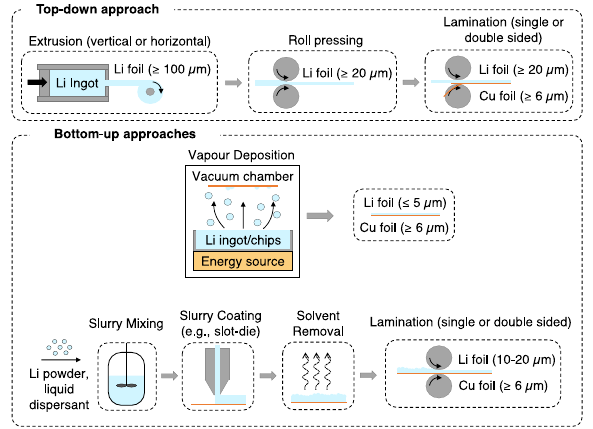
Fig. 5 | Production of lithium metal foils and electrodes. Top) Top-down method,i.e.,extrusionoflithiummetalingotstoproducelithiummetalfoilswitha minimum thickness of 100 µ m. Thickness can be reduced to a minimum of ca. 20 µ m by roll pressing. The foil can then be laminated on current collectors, such as copper. Bottom) Bottom-up approaches. The upper part of the bottom panel depicts asimpli fi edscheme of aphysicalvapour deposition method forproducing lithium foil. A lithium source, such as an ingot or chips, is placed in a vacuum chamber. Mechanical, electromagnetic, or thermal energy is then applied to the lithium source to vaporize the metal, which is deposited on a current collector, suchascopper,toactasanelectrode.Thelowerpartofthebottompaneldepictsa method for lithium ink deposition, wherestabilizedlithium particles are dispersed in a liquid (slurry mixing), and the slurry is coated on a foil and dried. The lithium metal electrode can then be thinned and laminated to homogenize and fl atten the (Fig. 5) 129 . Conventional lithium metal foil manufacturing (Fig. 5 top, top-down approach), generally carried out under a dry or inert atmo- sphere (which can add to processing costs), includes an extrusion process, and leads to foils with a minimum thickness of 100 µ m 130,131 . This thickness constitutes a large excess at the cell level (100 µ m ≈ 21 mAhcm − 2 ), particularly considering that the active lithium is gen- erally already containedinthepositive electrode material,with the cell assembled in a discharged state. A roll pressing procedure is com- monly employed for thinning lithium metal foils. Currently, state-of- the-art processes produce foils with a minimum thickness of 20 µ m and require the use of processing lubricants 131,132 .